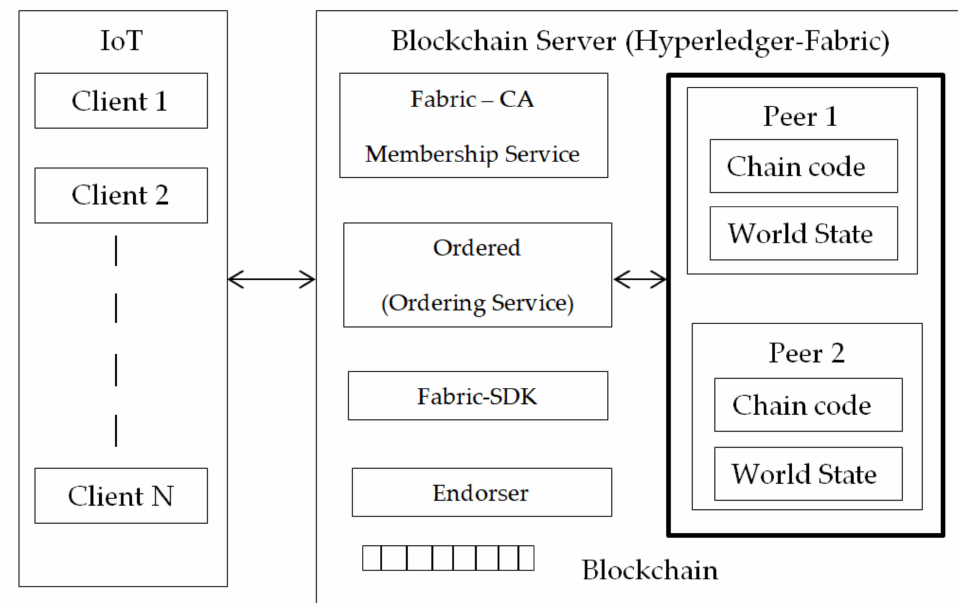
Figure 10. Architecture of blockchain implementation in IoT.